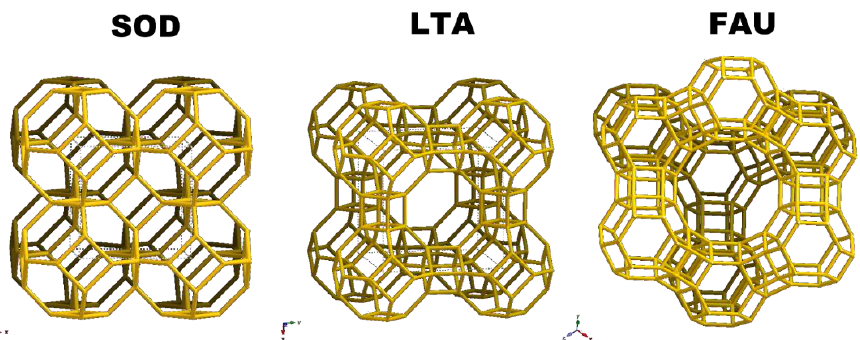
Figure 2. The framework structure for SOD (left), LTA (middle) and FAU (right) zeolitic